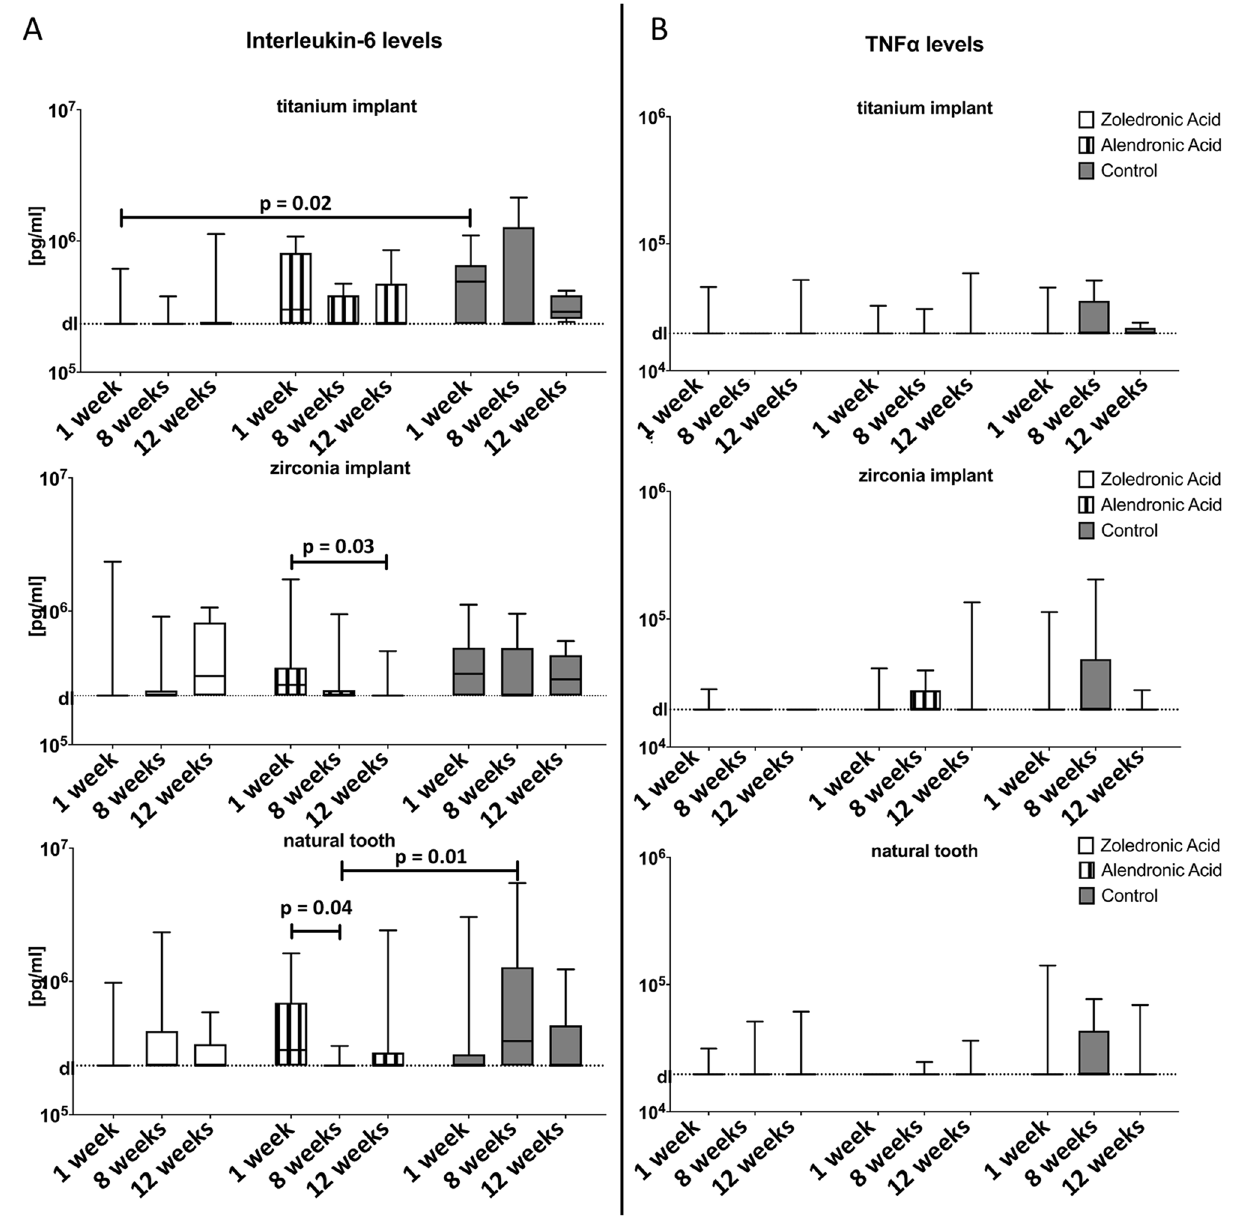
Figure 3. The evaluation for interleukin-6 and TNFα levels of both implant materials and the natural tooth were presented. The collection took place at three sessions: 1 week, 8 weeks, and 12 weeks after surgery. The detection limit was assessed for IL-6 at 233 ng/ml and for TNFα at 19.6 ng/ml after correction with dilution and recovery